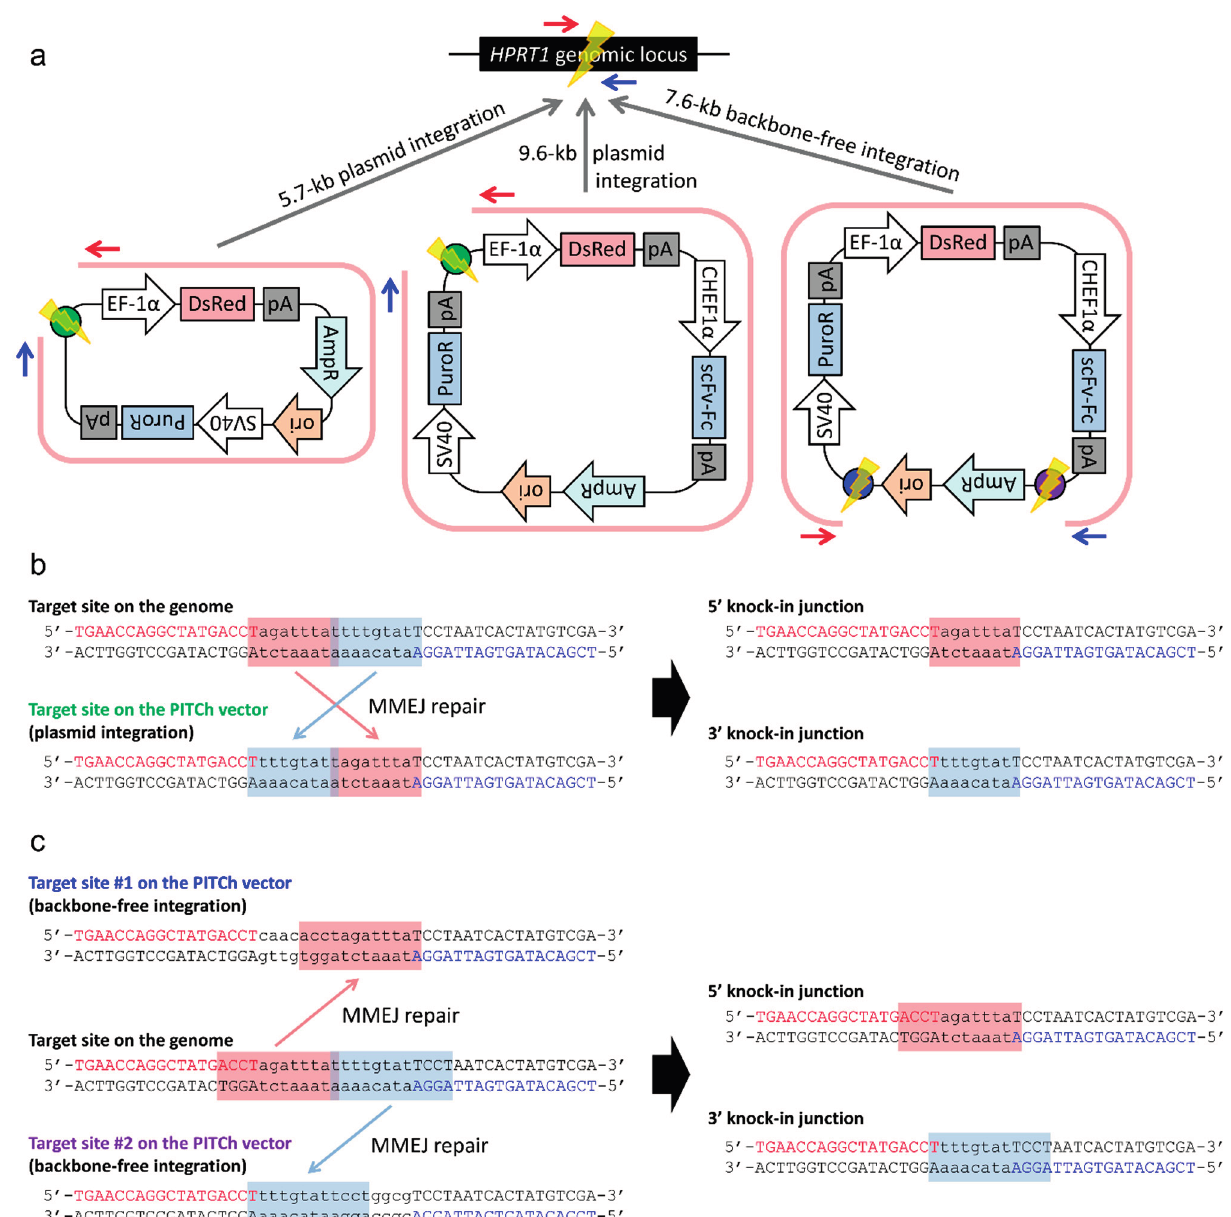
Figure 2. Schematic illustration of PITCh vectors and TALEN target sites. ( a ) Summary of the three kinds of PITCh vectors and knock-in experiments. Green, blue, and purple circles indicate TALEN target sites on the PITCh vector, related to ( b , c ). Yellow shapes indicate DNA double strand breaks. Pink lines indicate the regions that are expected to be knocked-in. Red and blue arrows indicate the positions of primers for the amplification of 5 ′ and 3 ′ junctions, respectively, related to Figure 3; ( b , c ) The TALEN target sites and knock-in junctions of plasmid integration ( b ) and backbone-free integration ( c ). Positions of each target site on the PITCh vector was shown in ( a ). Pink and blue boxes indicate designed microhomologies. Red and blue letters indicate the left and right TALEN target sequences, respectively. Lowercase letters indicate spacer